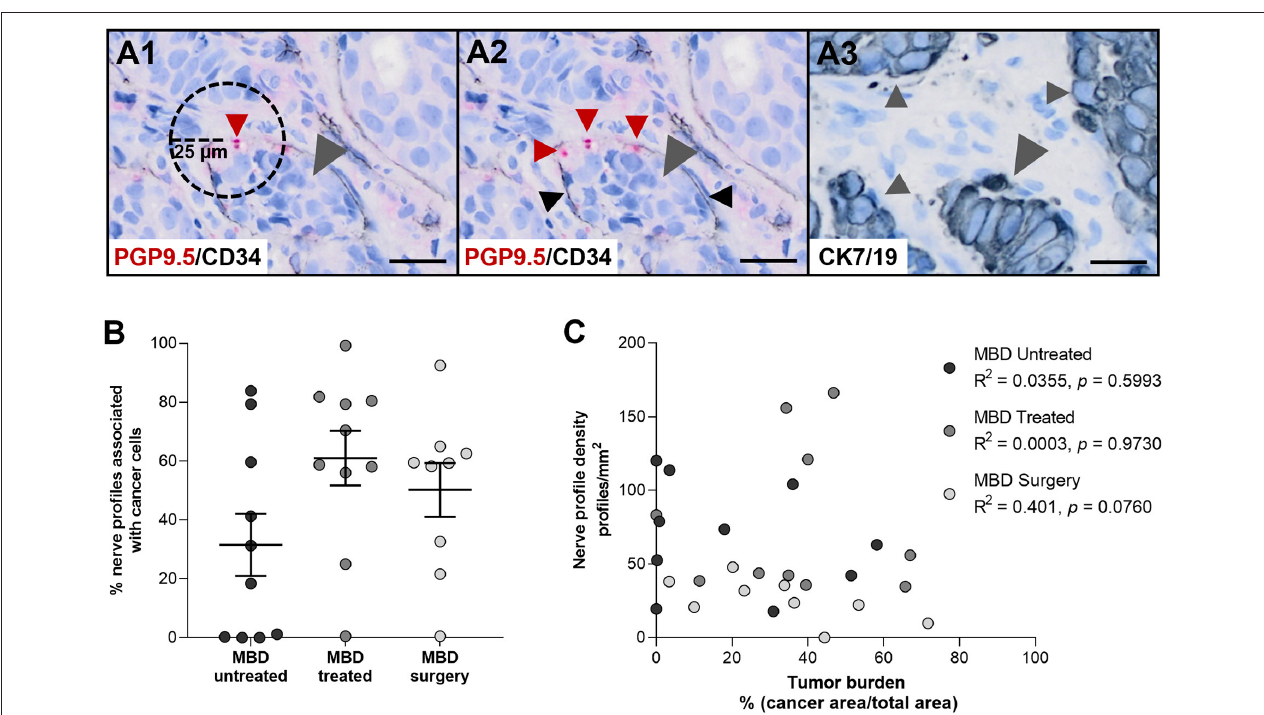
FIGURE 3 | Nerve profile density and tumor burden are not correlated. (A1) Illustration of the method. For each nerve profile it was determined if it was located within a distance of 25 µ m to cancer cells. (A2,A3) Representative illustration of nerve profiles found within 25 µ m of cancer cells in the bone marrow of a patient with metastatic bone disease (MBD). Sections were stained for protein gene product 9.5 (PGP9.5, red arrow heads) and CD34 [black arrow heads, (A2) ], while an adjacent section was stained for cytokeratin 7 and 19 [CK7/19, gray arrow heads, (A3) ] to identify cancer cells. (B) No difference was found in the percentage of nerve profiles found within 25 µ m of cancer cells in between the three groups of cancer-infiltrated bone tissue. (C) No correlation was found between the nerve profile density and the tumor burden, neither overall nor in any of the subgroups. Analyses were performed with Kruskal–Wallis one-way analysis of variance followed by Dunn’s multiple comparisons test and Spearman correlation. Data are presented as mean ± SEM. Scale bars: 25 µ m.